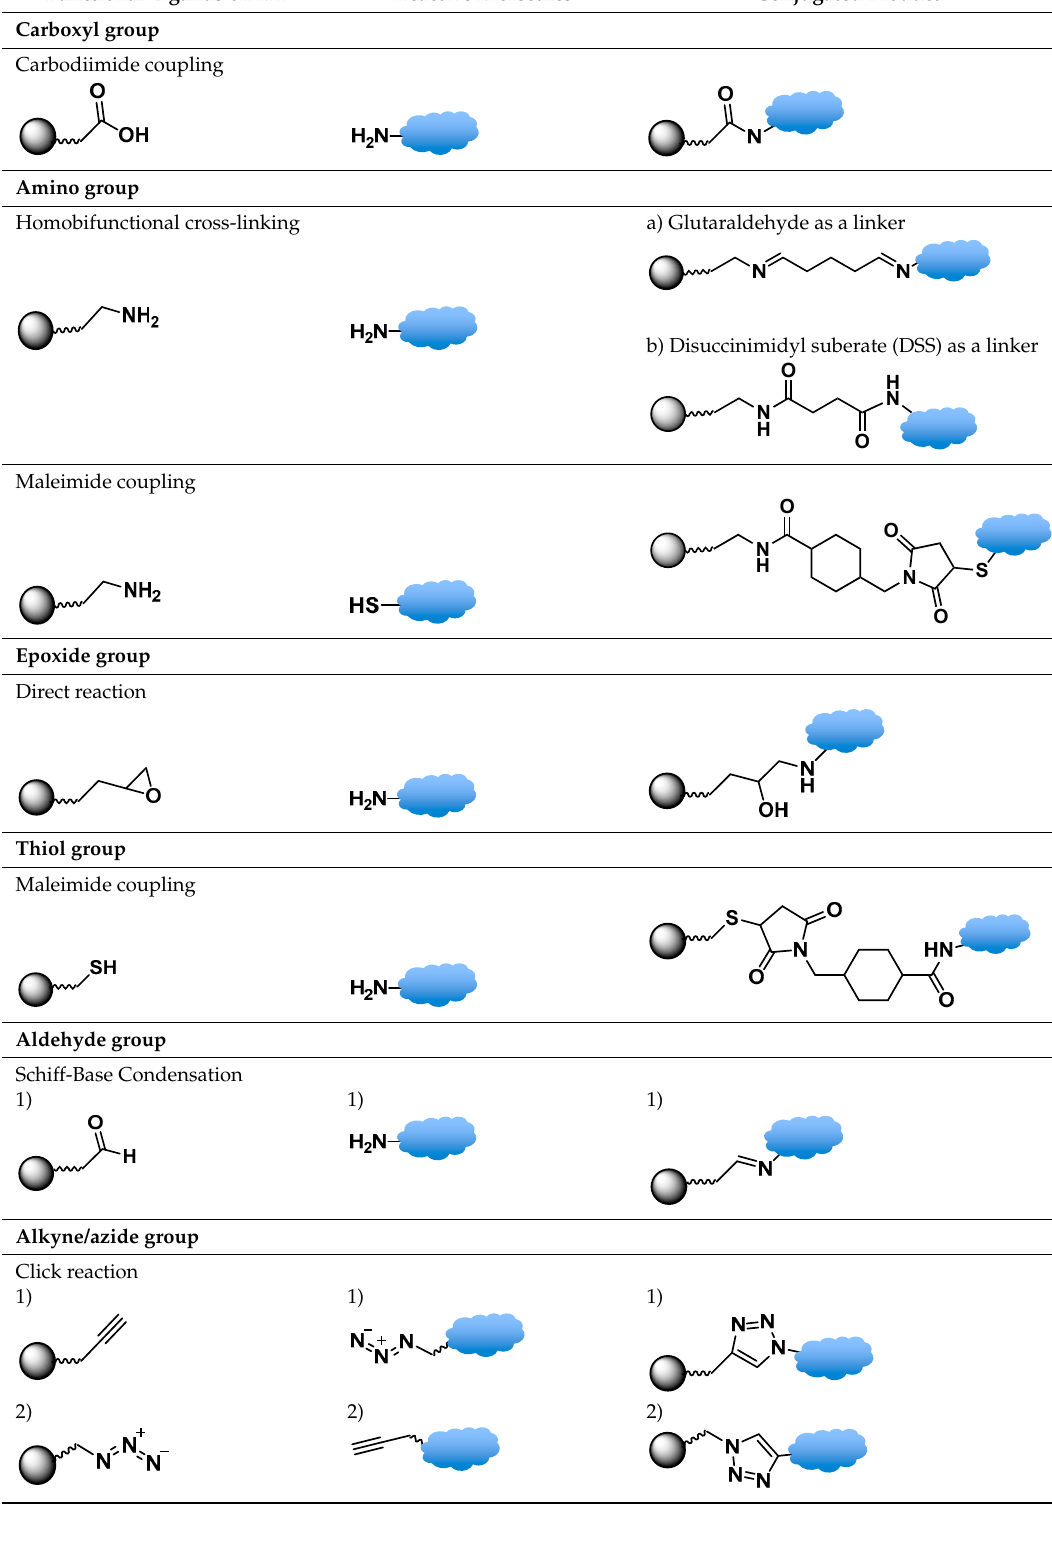
Table 2. Common Bioconjugation Strategies.